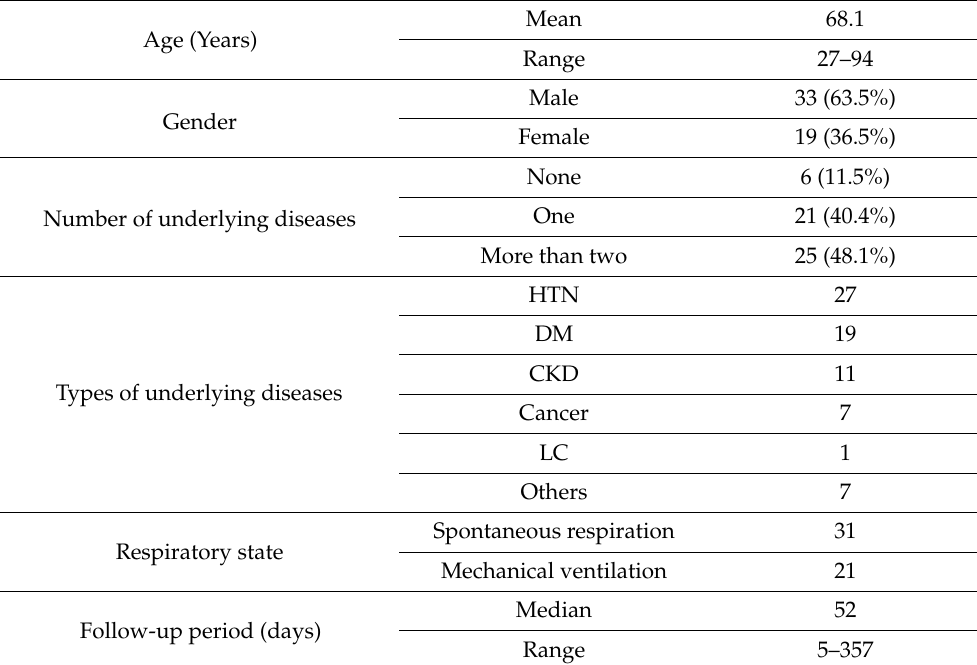
Table 1. Patients’ demographics and clinical characteristics.